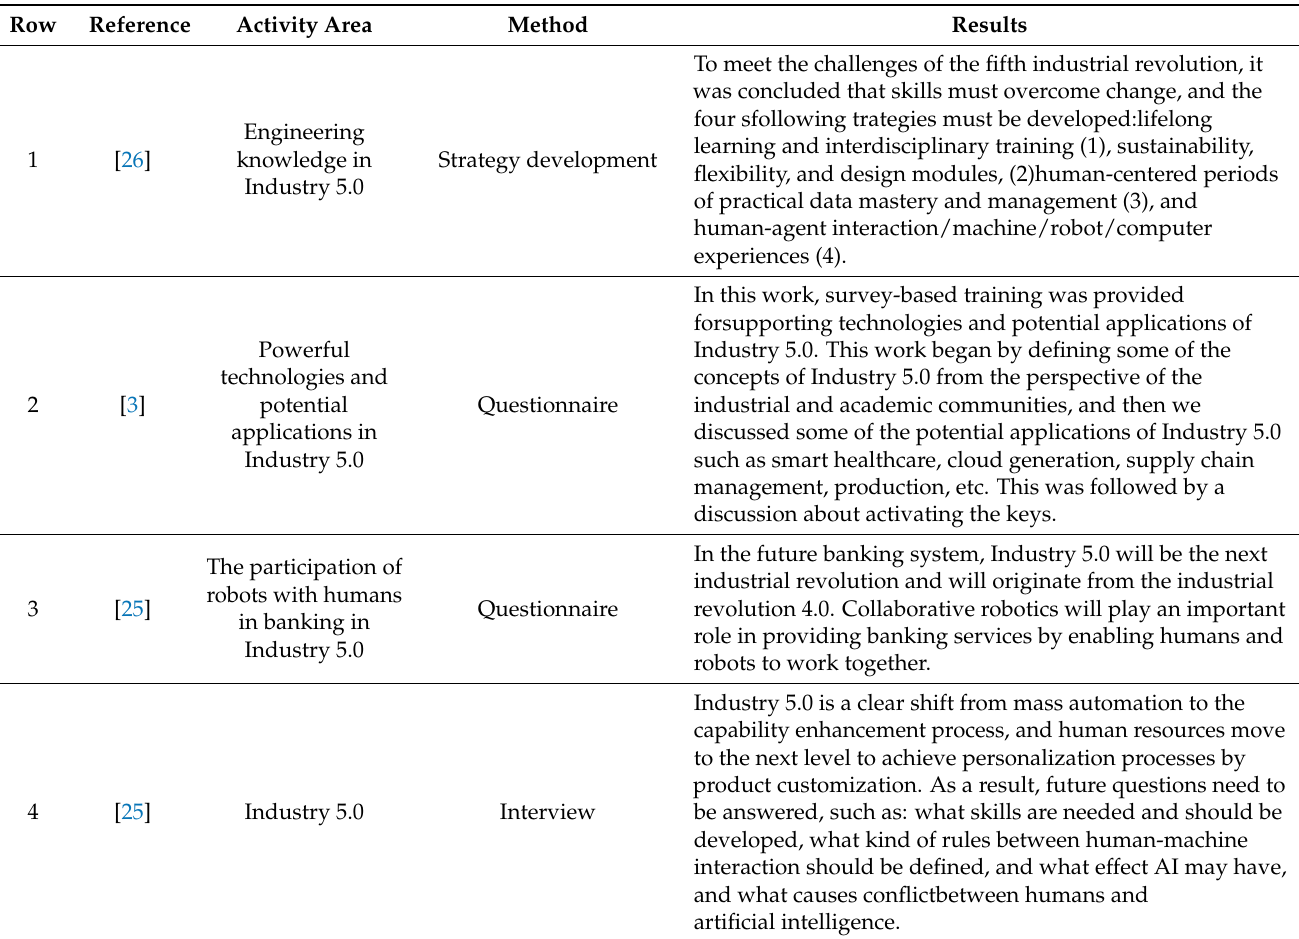
Table 2. Research background (Ref.